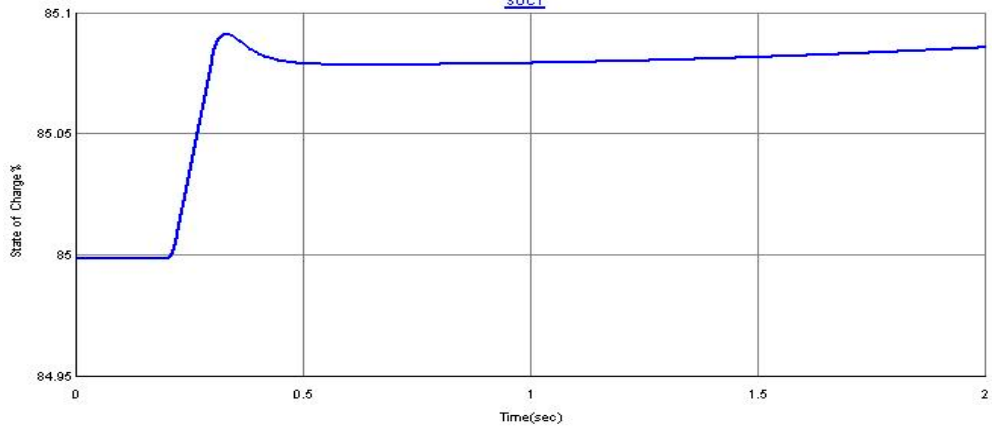
Figure 11. State of charge (SOC) of the battery.